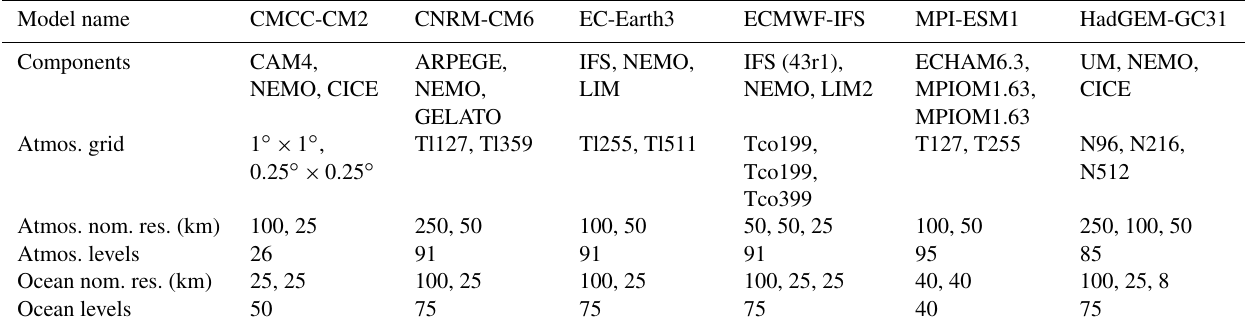
Table 1. Models used in the analysis, listed with their components (atmosphere–ocean–ice models), the atmospheric grid used for the two versions (low- and high-res), the nominal resolution and the number of levels used for the atmosphere and ocean components. Note that for HadGEM-GC31 (LL, MM, HH) and ECMWF-IFS (LR, MR, HR) we also considered an intermediate-resolution